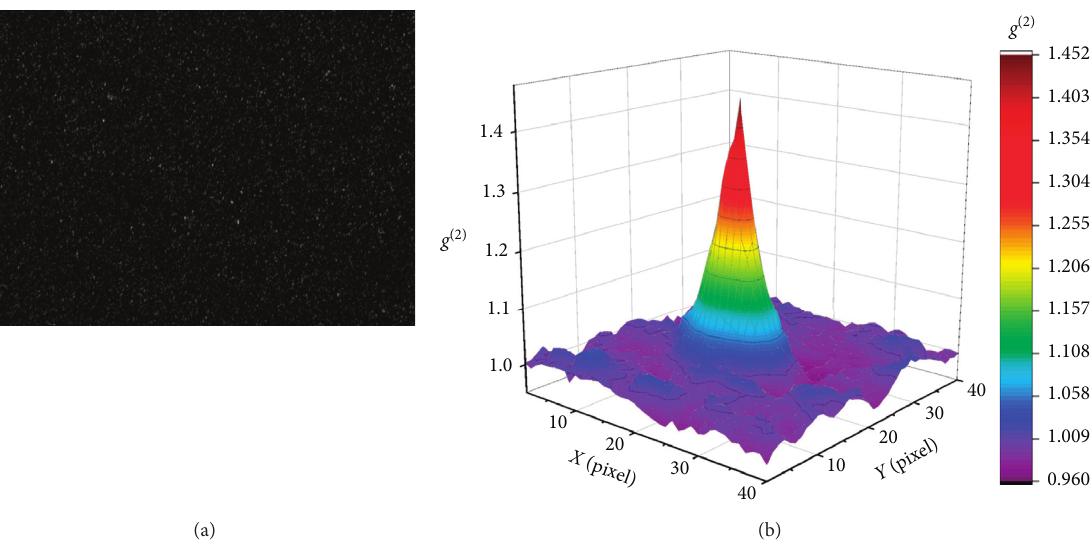
Figure 7: The measured g ( 2 ) value of the actively Q -switched laser generating pseudothermal light: (a) the image achieved by CCD; (b) the corresponding pseudo-colour map of the second-order correlation function.